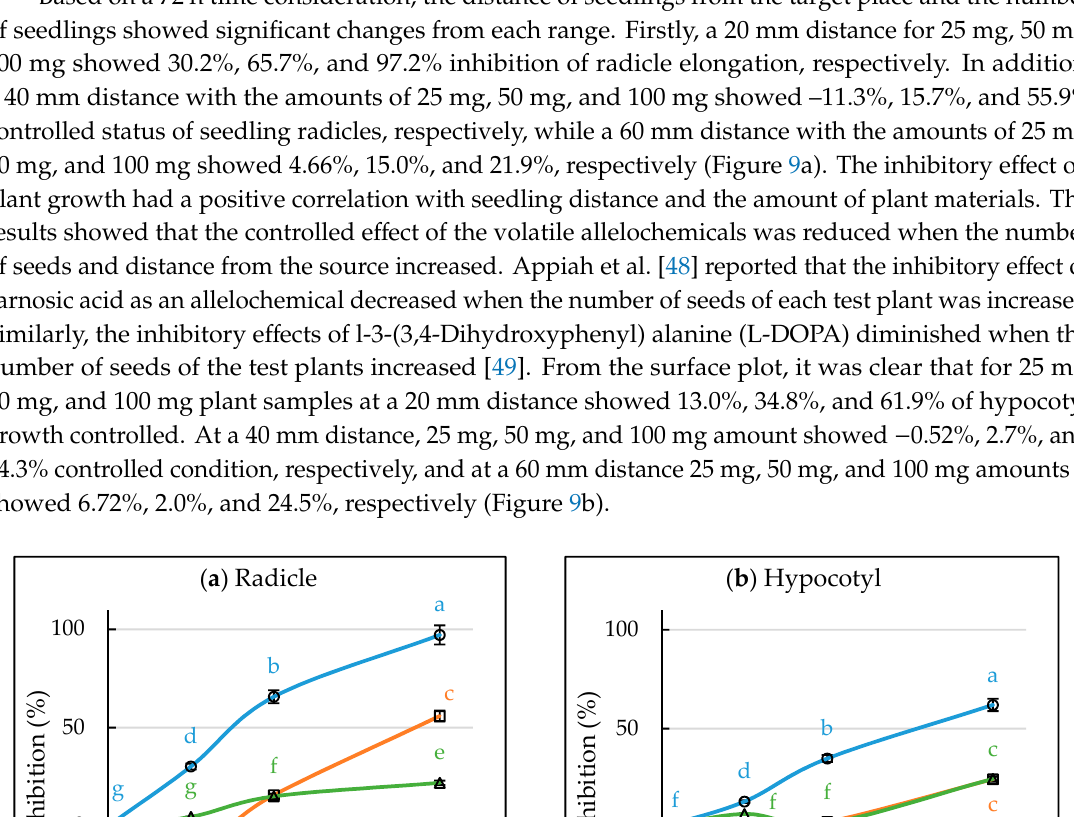
Figure 8. Growth level evaluated by the SPD, method considering 100 mg dry pericarp of S. mukorossi with a distance of 20 mm, compared with a control treatment on L. sativa seedlings’ radicle and hypocotyl.